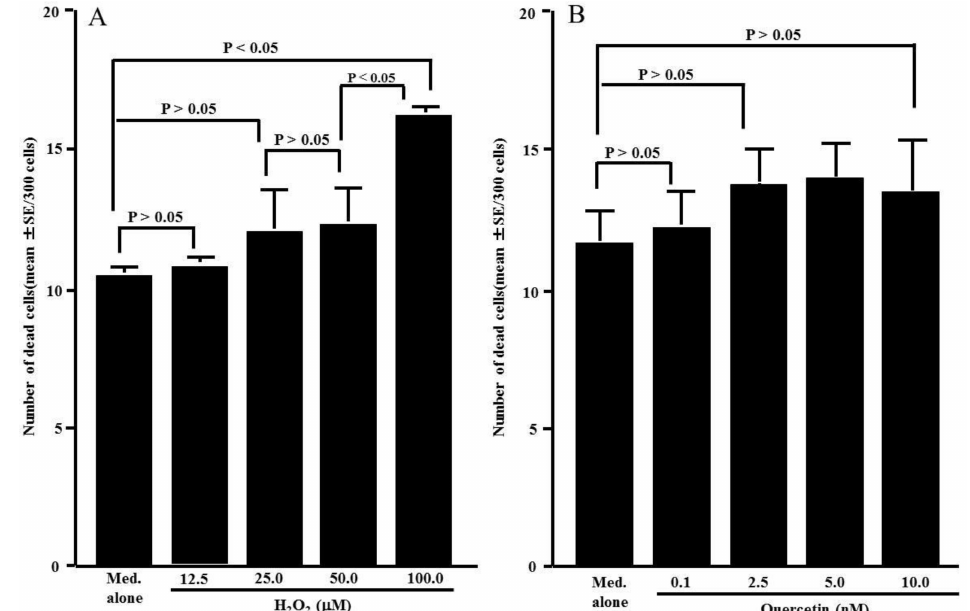
Figure 3. Influence of H 2 O 2 ( A ) and quercetin ( B ) on cell viability. Nasal epithelial cells (5 × 10 5 cells) were stimulated with various concentrations of either H 2 O 2 or quercetin for 24 h. The trypan blue exclusion test was performed, and the number of dead cells was counted out of 300 total cells. The data are expressed as the mean number of dead cells ± SE of triplicate cultures. One representative experiment of two is shown in this figure. Med. alone: Medium